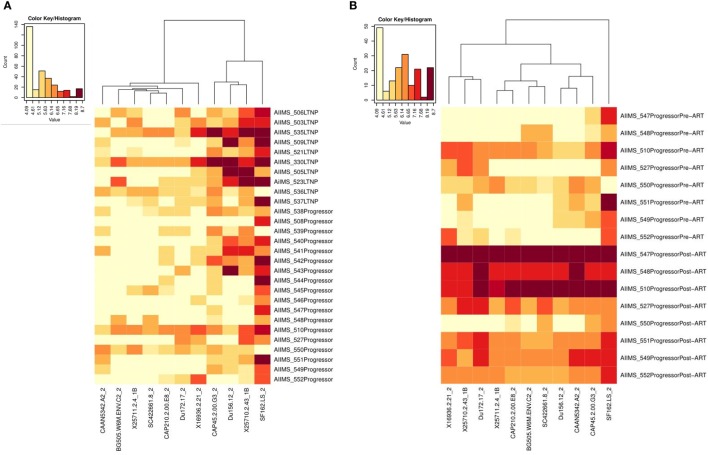
Heat-map analysis of ID50 titers of plasma samples from HIV-1-infected children based on hierarchical clustering and transformed natural log data of ID50 values. (A) shows comparison of ID50 titers of 10 ART naive long-term non-progressors (LTNPs) and 18 progressors, and (B) shows comparison of ID50 titers of 8 progressors pre-ART and post 6–12 months of ART against a panel of 11 virus strains. In the heat-map, each row shows the natural log ID50 values for each plasma sample, while the columns display the viruses. Darker color represents better neutralizing activity. Alpha numerals given after the underscore along with the viruses indicate the tier of the virus.